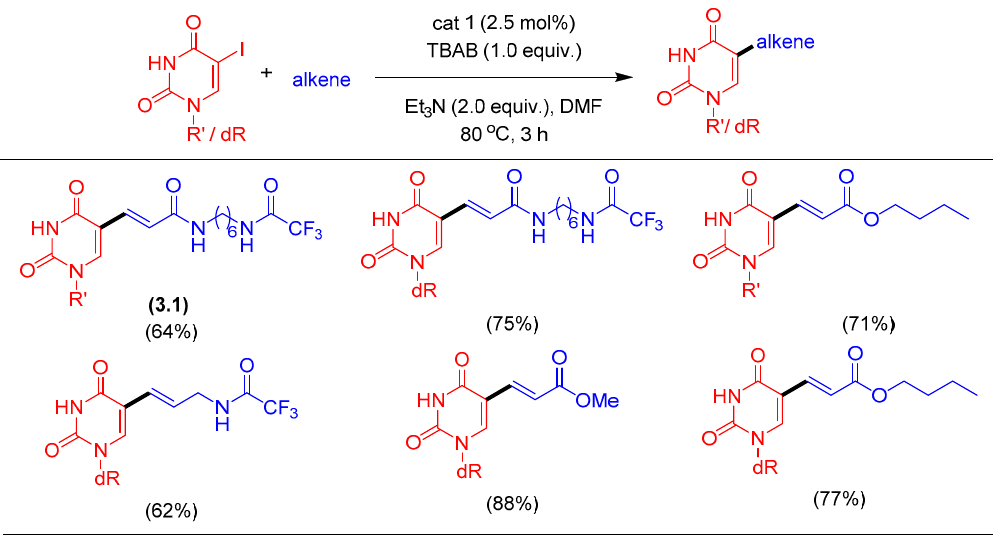
Figure 4. List of water-soluble phosphine ligands. 1.2. Suzuki-Miyaura Cross-Coupling Using cat 2.